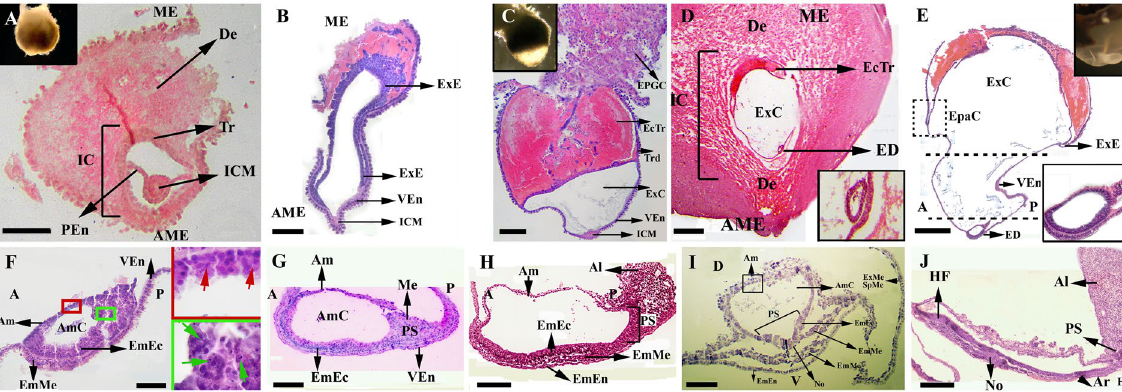
Figure 1. Sagittal sections of the early post-implantation embryo of Lagostomus maximus . ( A ) Newly implanted embryo (22–26 days post-fertilization). ( B ) Pre-streak stage, elongated embryo; note that the embryonic and extra-embryonic tissues are far apart. ( C ) Differentiation of the embryo (26–32 days post- fertilization) with the ectoplacental trophoblast invaded by maternal blood; exocoelomic cavity formed. Note the mesometrially situated, ectoplacental giant cells (EPGC). ( D ) General view of the implantation chamber, with the embryo disc at the anti-mesometrial pole (26–32 days post-fertilization). Inset: detail of the embryonic disc. ( E ) Embryonic disc with allantoic bud in the neural plate stage. Note the extraembryonic ectoderm far apart from the cavitated epiblast, separated by the visceral endoderm (dotted lines). Inset: detail of the embryonic disc. ( F ) Embryonic cavitation; upper inset: cells undergoing apoptosis in the amniotic cavity (red arrows); lower inset: cells in apoptosis in the epiblast (green arrows). ( G ) Primitive streak stage: appearance of some mesoderm cells in the posterior region of the epiblast that lines the visceral endoderm. ( H , I ) Neural plate stage (32–39 days post-fertilization): appearance of the node. ( J ) Late head-fold stage: foregut invagination, the extension of the allantois. A: anterior; Al: allantois; Am: amnion; AmC: amniotic cavity; AME: antimesometrial; Ar: archenteron; D: dorsal; De: decidua; EcTr: ectoplacental trophoblast; ED: embryonic disc; EmEc: embryonic ectoderm; EmEn: embryonic endoderm; EmMe: embryonic mesoderm; Ep: epiblast; EpaC: epamniotic cavity; EPGC: ectoplacental giant cells; ExC: exocoelomic cavity; ExE: extraembryonic ectoderm; ExMe: extraembryonic mesoderm; Hp: hindgut pocket; IC: implantation chamber; ICM: inner cell mass; ME: mesometrial; No: node; P: posterior; PEn: primitive endoderm; PS: primitive streak; SpMe: splanchnic mesoderm; Tr: trophectoderm; Trd: trophoblast-derived cells; V: ventral; VEn: visceral endoderm. Scale bar: 100 µ